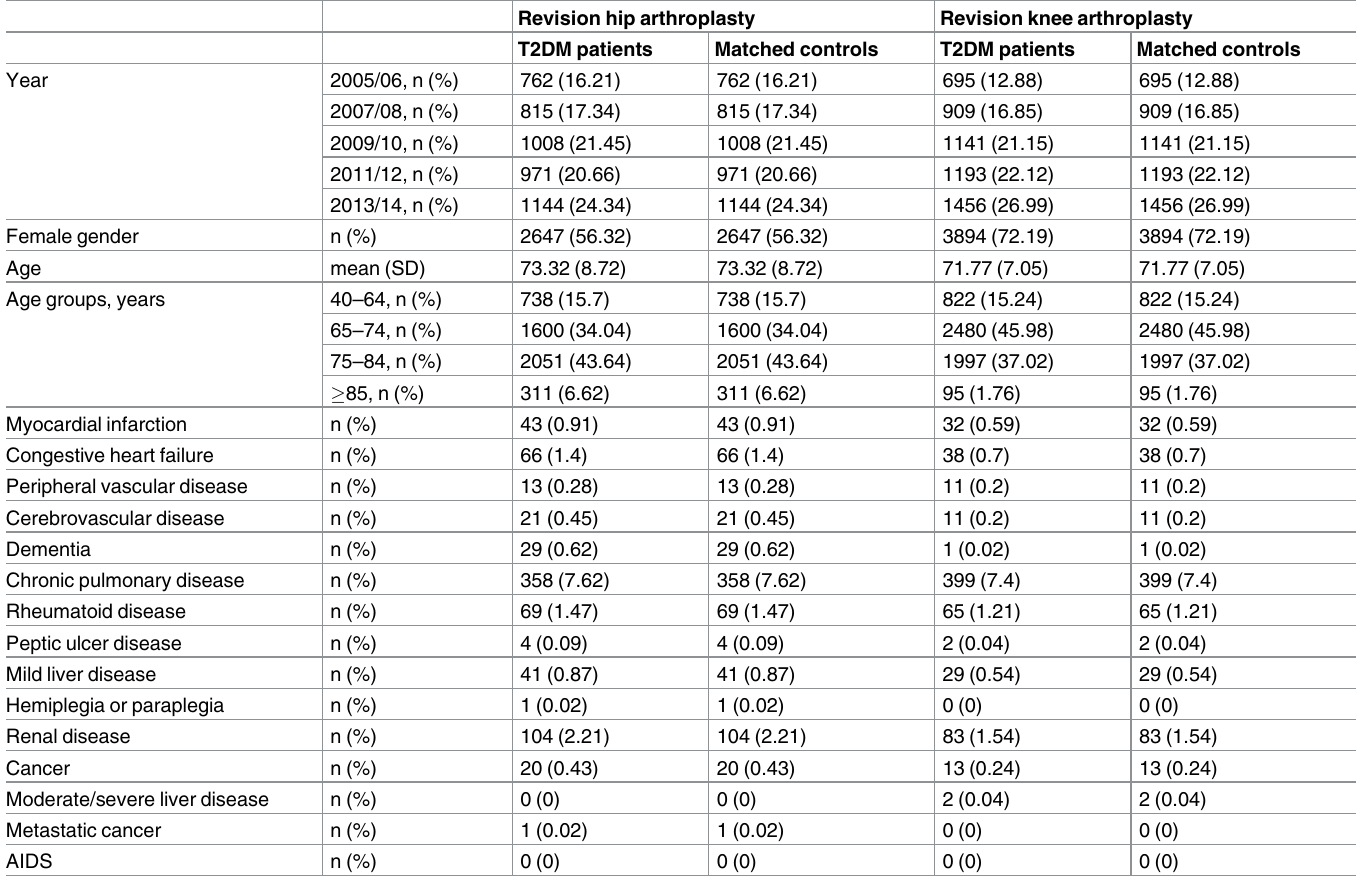
Table 2. Characteristics and comorbidities of patients with type 2 diabetes and non diabetic matched controls who underwent revision total hip arthroplasty and revision total knee arthroplasty in Spain, 2005–2014,according to the Charlson comorbidity index